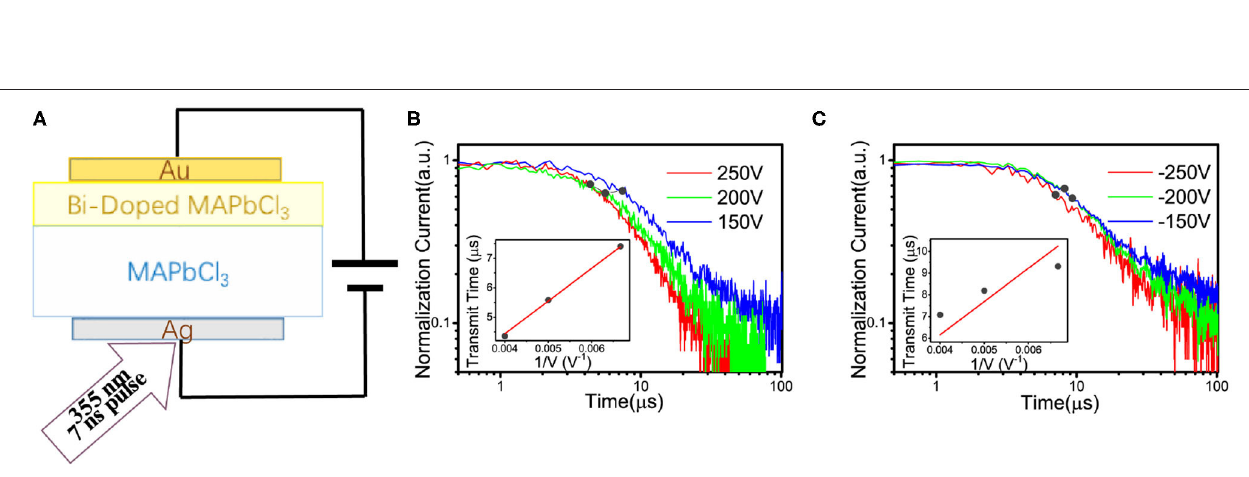
Frontiers in Physics | www.frontiersin.org